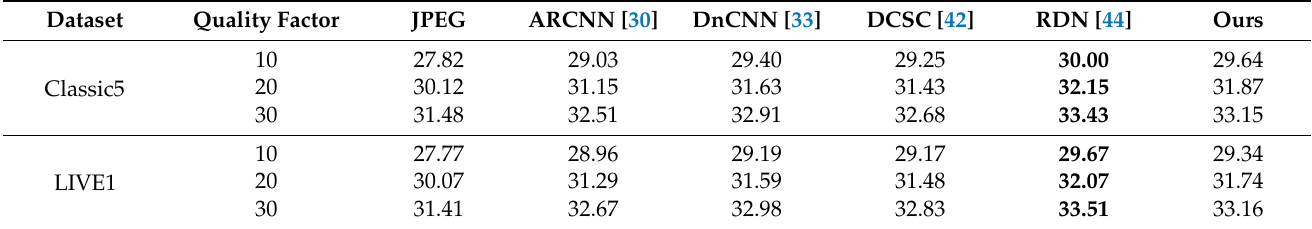
Table 6. PSNR (dB) comparisons on the test datasets. The best results of dataset are shown in bold. Dataset